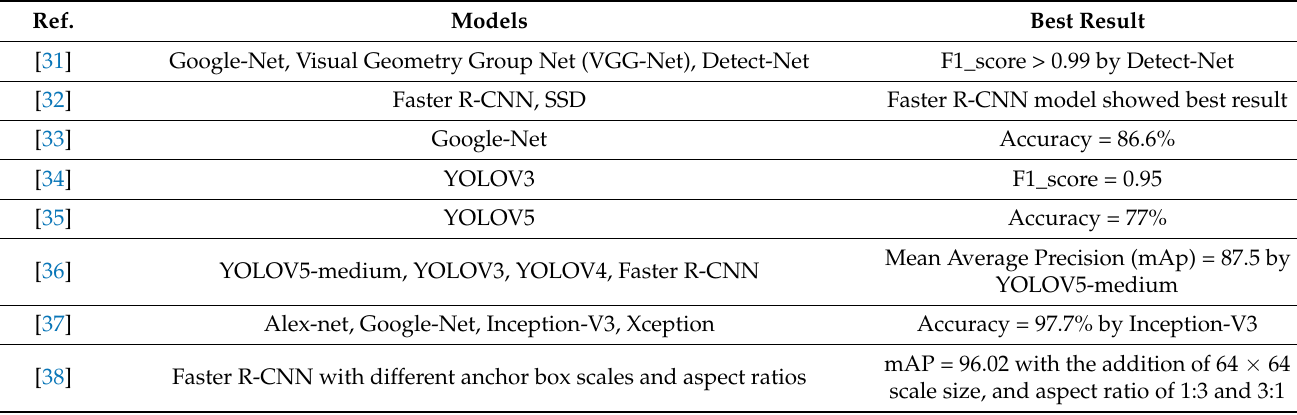
Table 3. Weed-detection-related work using DL